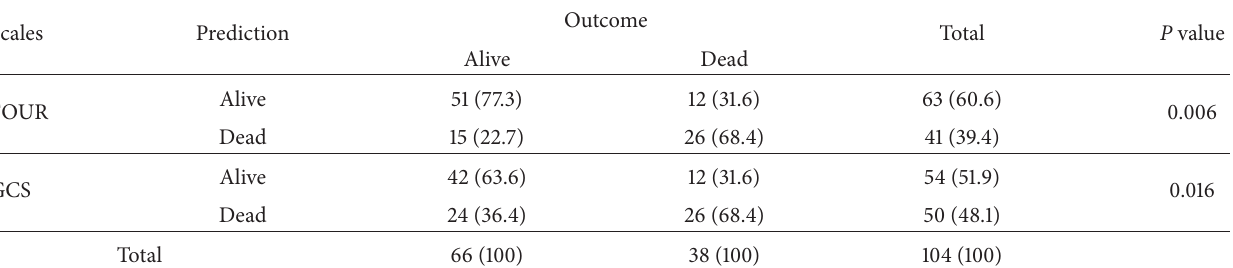
Table 3: Agreement between two scales for patient’s outcome: no